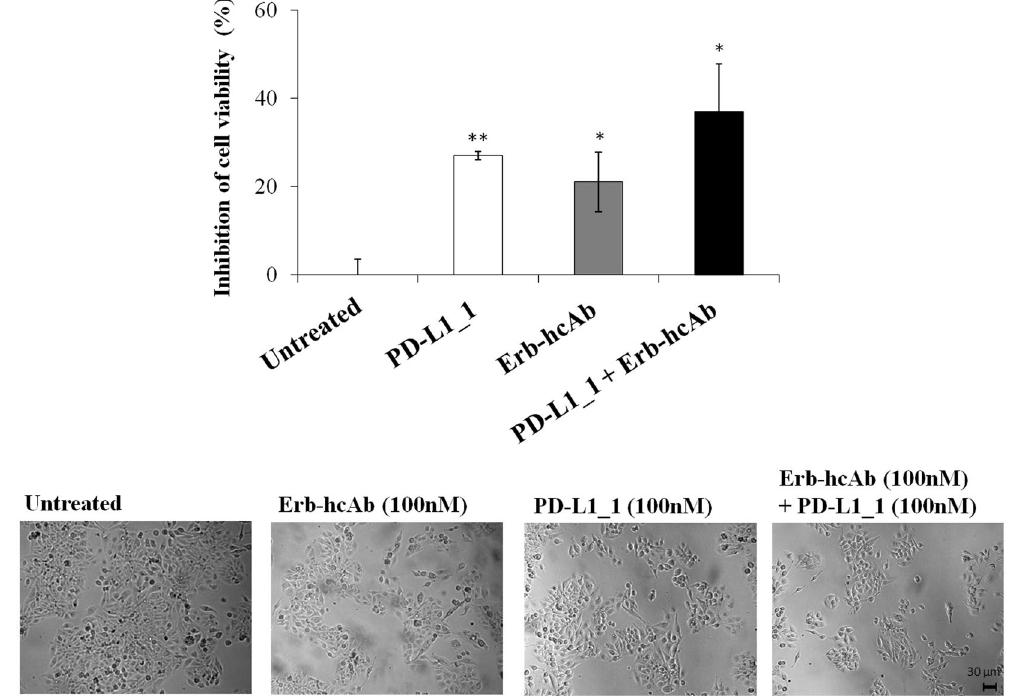
Figure 8. Combinatorial treatment of PD-L1_1 with Erb-hcAb on JIMT-1 tumor cells. Effects on tumor cell survival of Erb-hcAb and PD-L1_1, alone or in combination, at the indicated concentrations on JIMT-1 cell lines. Cell survival is expressed as percent of viable treated cells with respect to untreated cells. The images show some fields of cultures of cells untreated or treated with each indicated compound or with the indicated combination. Error bars depicted means ± SD. P values for the indicated mAbs relative to untreated cells, are: ** P < 0.01; * P < 0.05. Scale bar = 30 μ